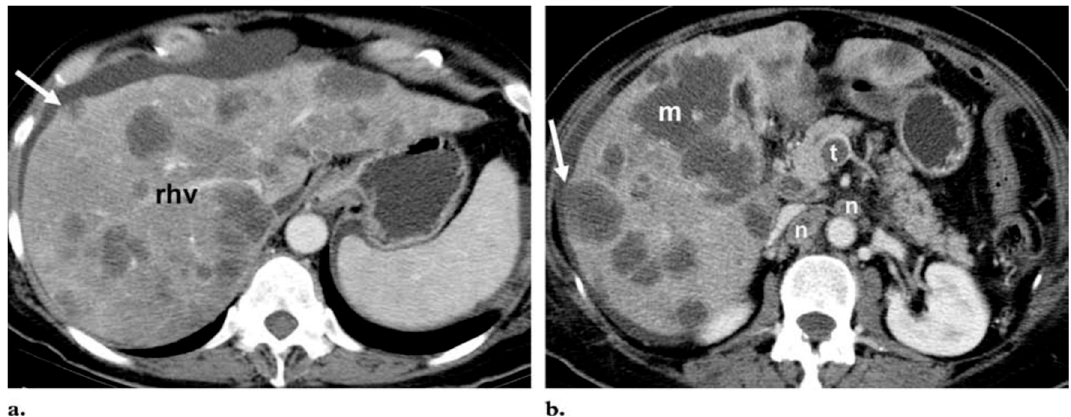
Figure 3. Differentiation of metastases from fat deposition in the liver. Axial portal venous phase contrast-enhanced CT images at the level of the right hepatic vein (rhv) ( a ) and the pancreatic head ( b ) show innumerable hypoattenuated lesions throughout the liver. Most of the lesions are round or oval, but the largest ( m in b ) has a geographic configuration. Because of their low attenuation (<40 HU), the lesions might be mistaken for multifocal fat deposition; however, the mass effect of the lesions, which produces bulging of the liver surface (arrow) and compression of the right hepatic vein, as well as the multiplicity of lesions, their predominant round or oval shape, the thrombus ( t in b ) in the superior mesenteric vein, and numerous heterogeneous lymph nodes ( n in b ), are suggestive of malignancy. The lesions were identified as hematogenous metastases from pancreatic adenocarcinoma. Figure reproduced with permission from Hamer et al. [55].